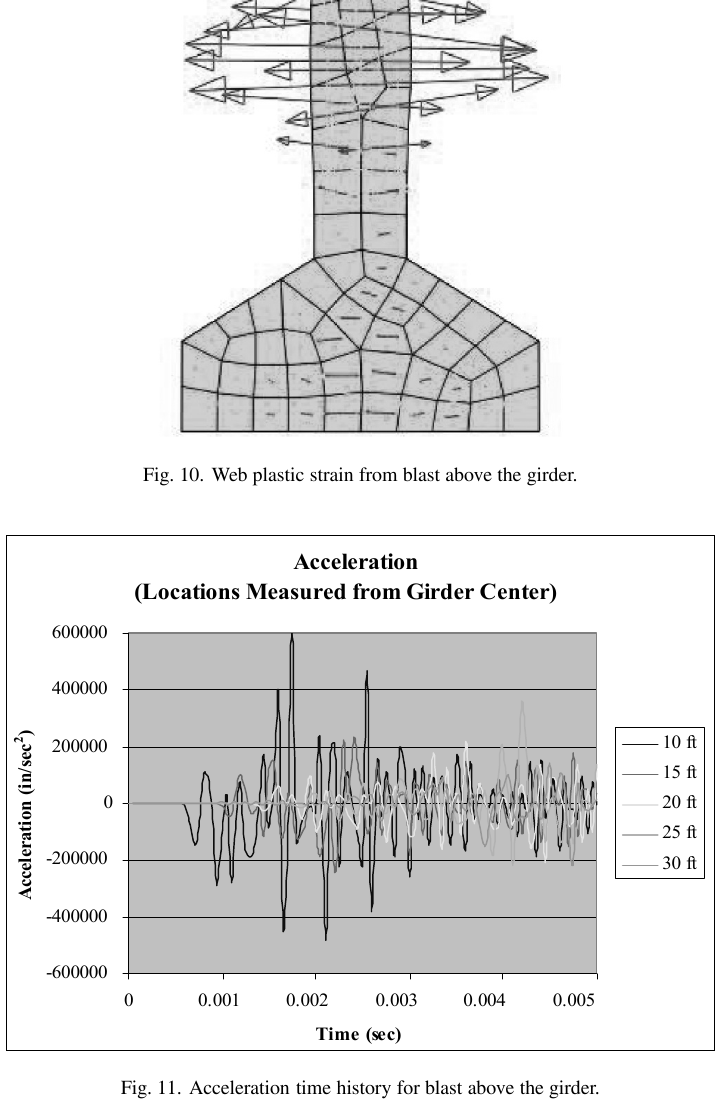
Fig. 11. Acceleration time history for blast above the